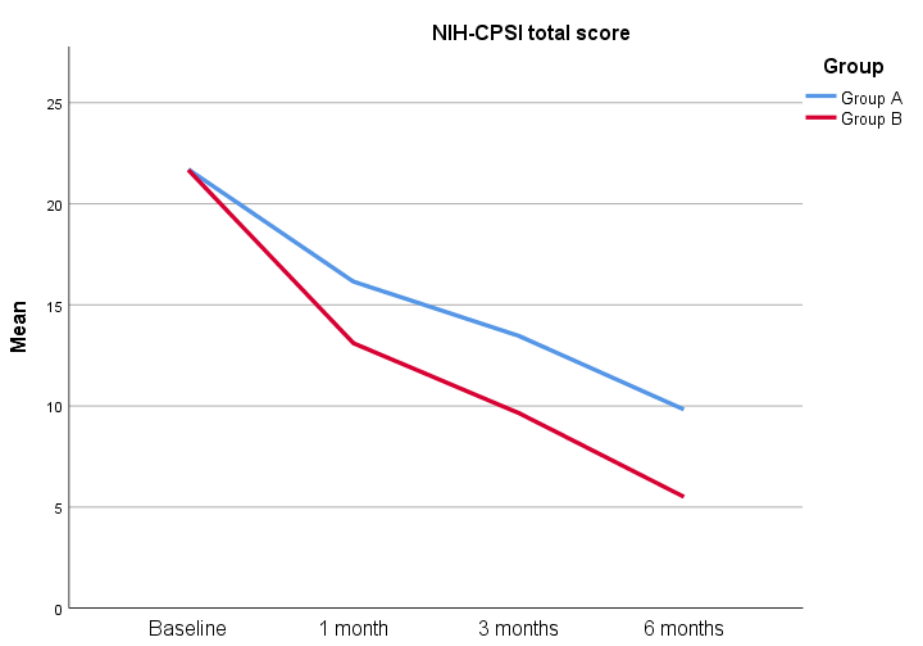
Figure 1. IPSS score from baseline to 6 months after treatment.